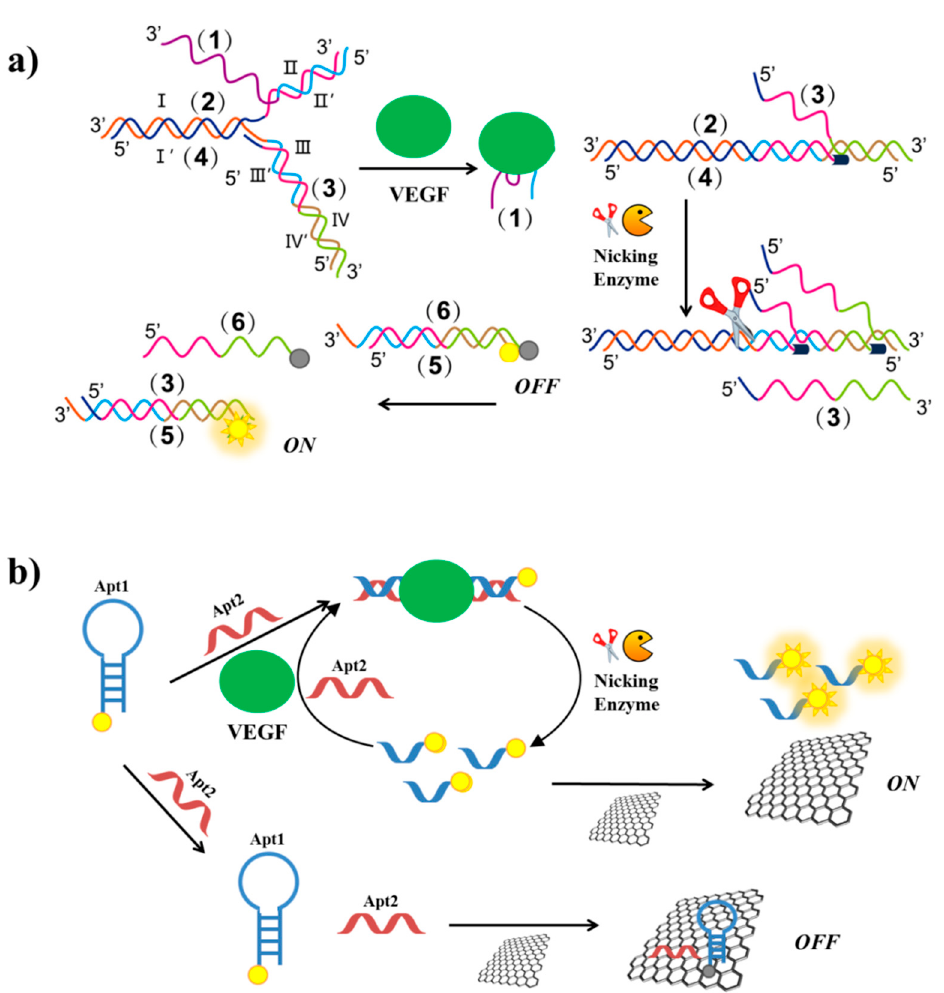
Figure 16. Schematic representation of VEGF detection strategies exploiting nicking endonuclease enzymes, based on DNA assembly structure switching and isothermal amplification after enzyme cleavage ( a ) and VEGF aptamer splitting into two subunits and fluorescence enhancement after target recognition and enzyme cleavage ( b ). Figure 16a is adapted from reference. [132].